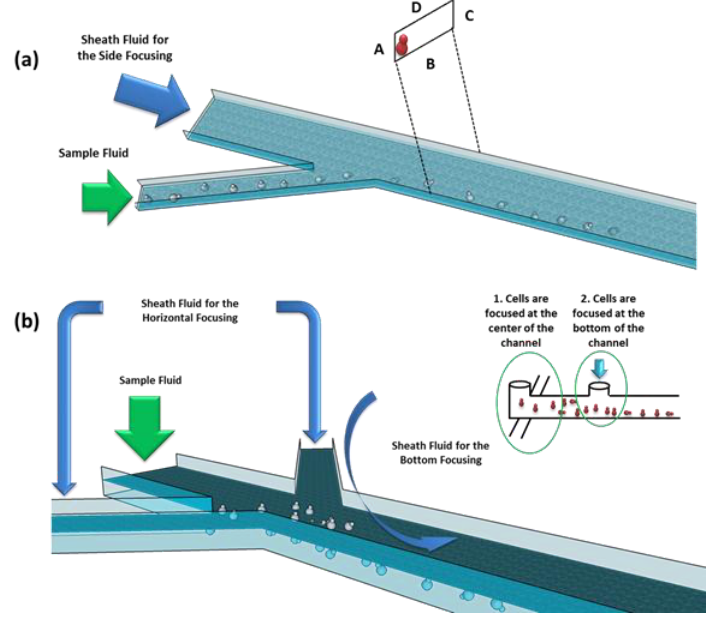
Figure 6. Schematic of the realized devices for the ( a ) in-plane and ( b ) out-of-plane hydrodynamic